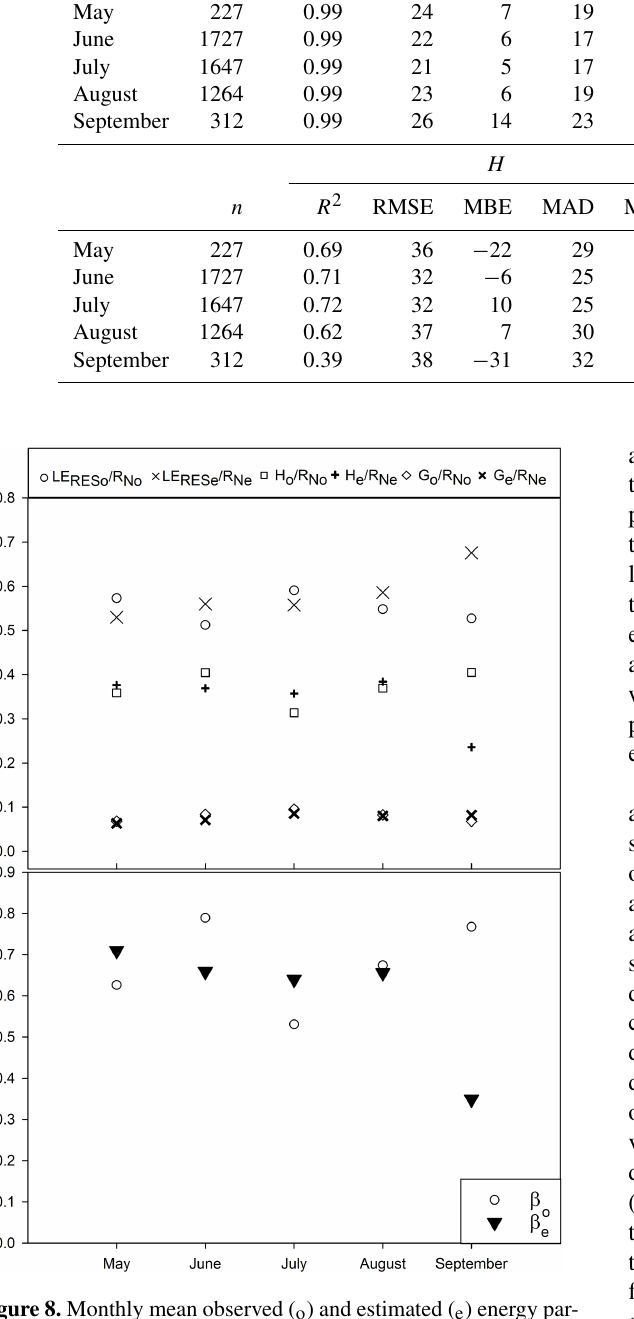
Figure 8. Monthly mean observed ( o ) and estimated ( e ) energy par- titioning (LE / RN, H / RN and G/ RN) and Bowen ratio ( β ) for all flux stations from 2008 to 2012 using α PTC of